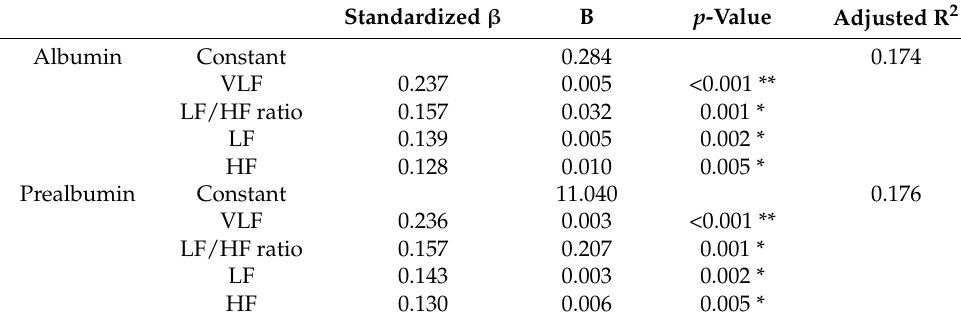
Table 6. Multiple regression analysis between nutritional markers and HRV